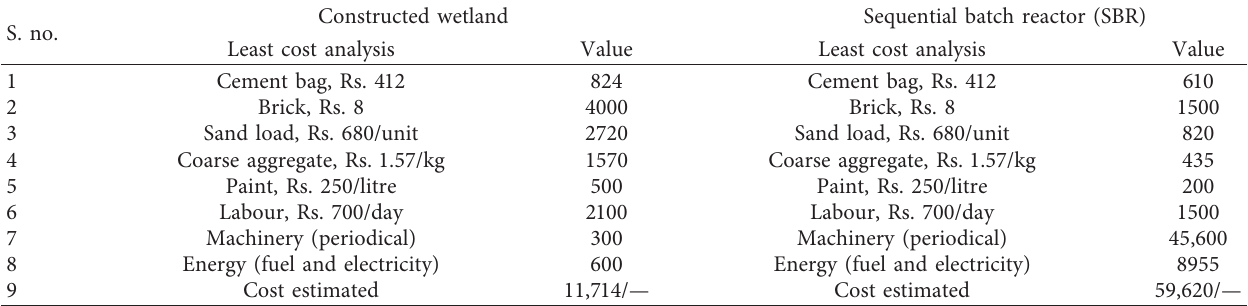
Table 4: Cost analysis for treatment of one cubic meter